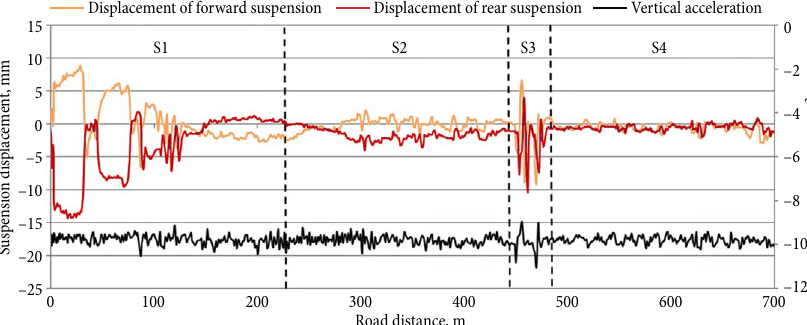
Fig. 5. Vehicle motions in vertical axis, v = 50 km/h